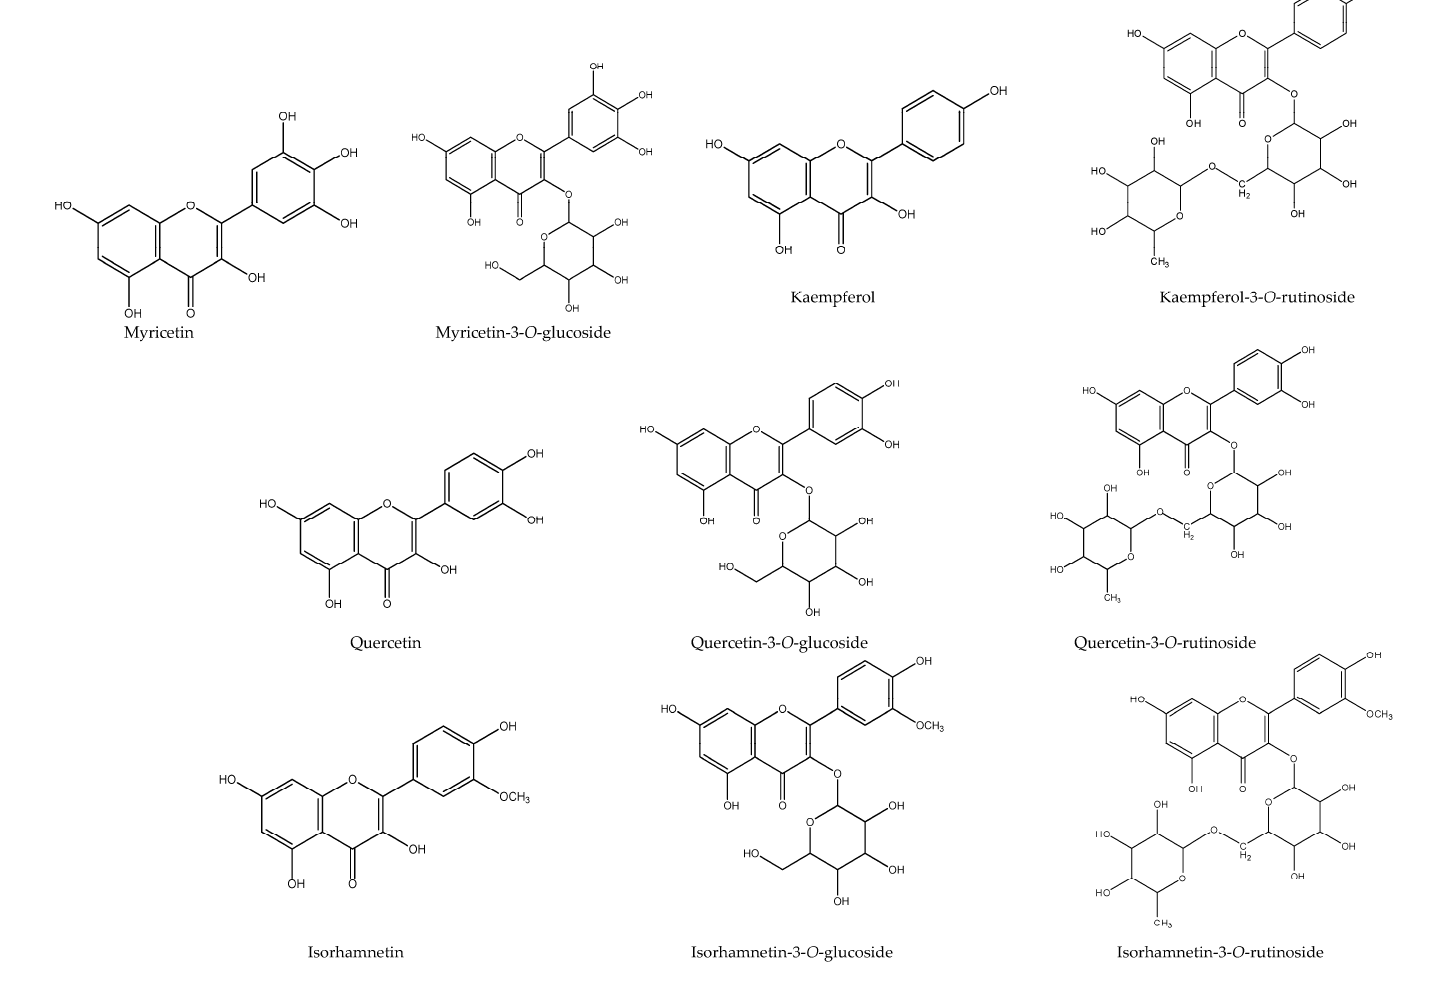
Figure 2. Flavonols’ chemical structures.